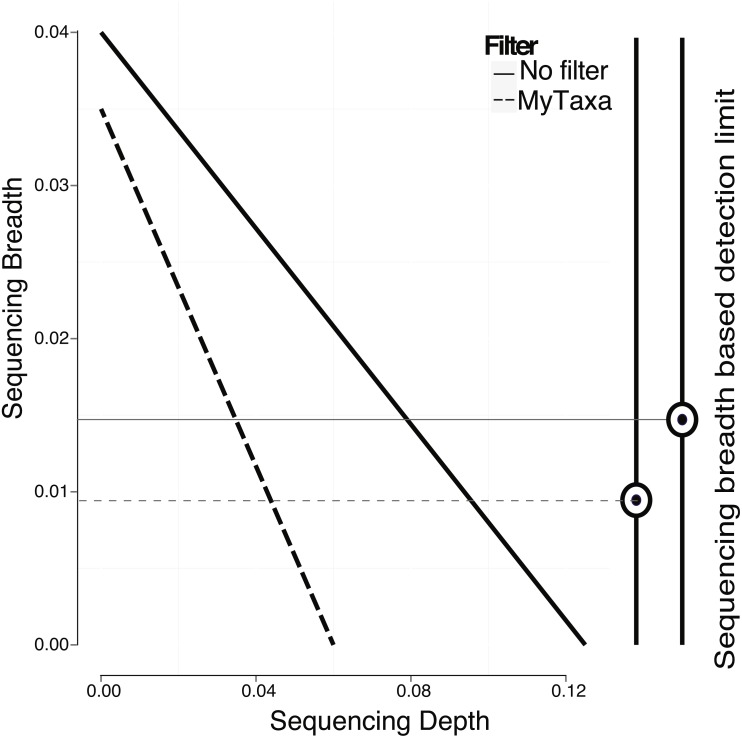
Effect of filtering of less informative genes by MyTaxa on minimum sequencing breadth and depth.Genome regions of the E. coli target genome were classified by MyTaxa, and regions with low scores (bottom 5%) or no scores because the corresponding genes were not indexed by MyTaxa were excluded from further analysis (filtered genome). Note that detection limit for the filtered genome (dashed line) is lower than the unfiltered genome (solid line).